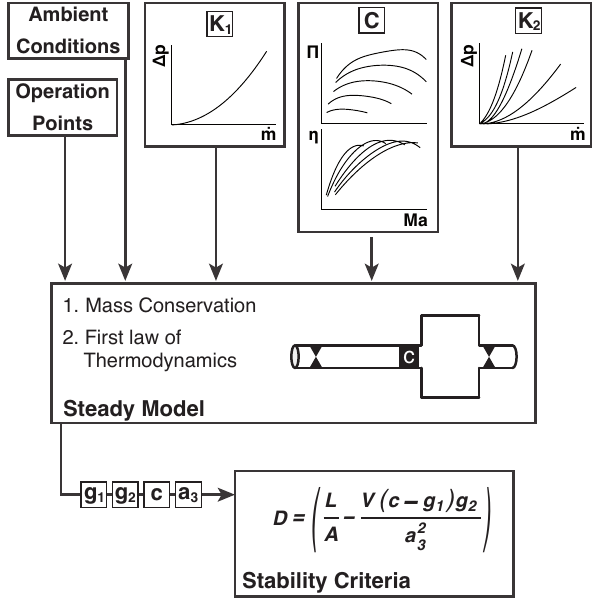
Figure 4. The steady analytic model